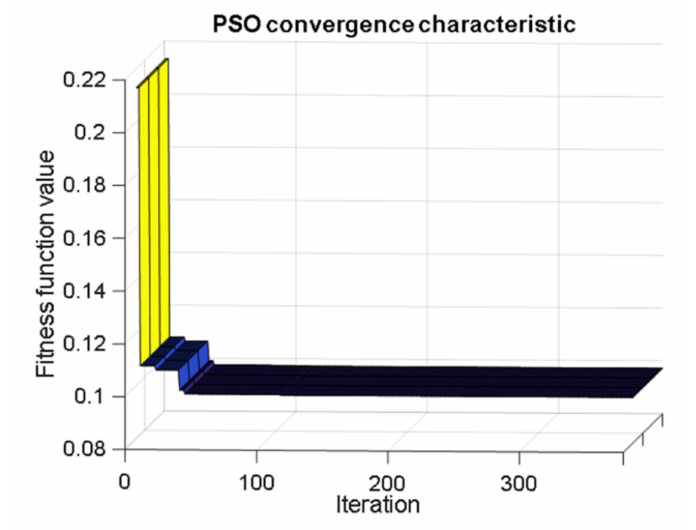
Figure 17. PSO convergence characteristic